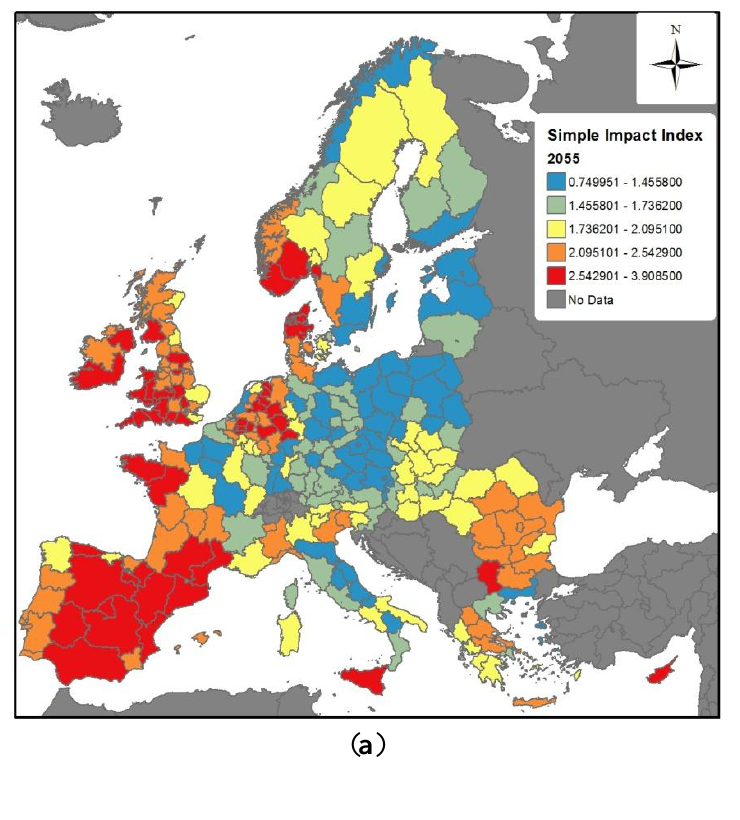
Figure 4. Vulnerability Index projected for 2055. ( a ) Impact Index; ( b ) Vulnerability